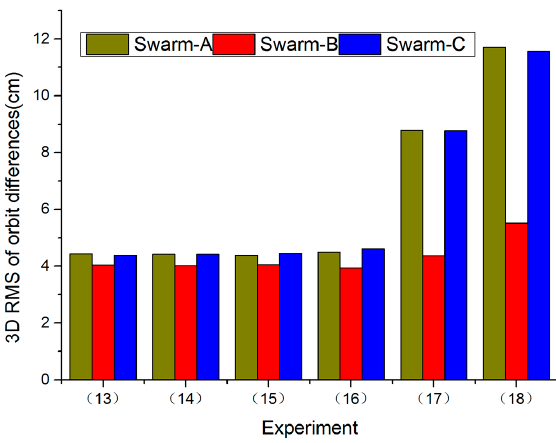
Figure 4. RMS values of orbit differences for all Swarm satellites in 3D direction between Swarm POD and PSOs released by ESA from Experiments (13) to (18), 1 November 2014.